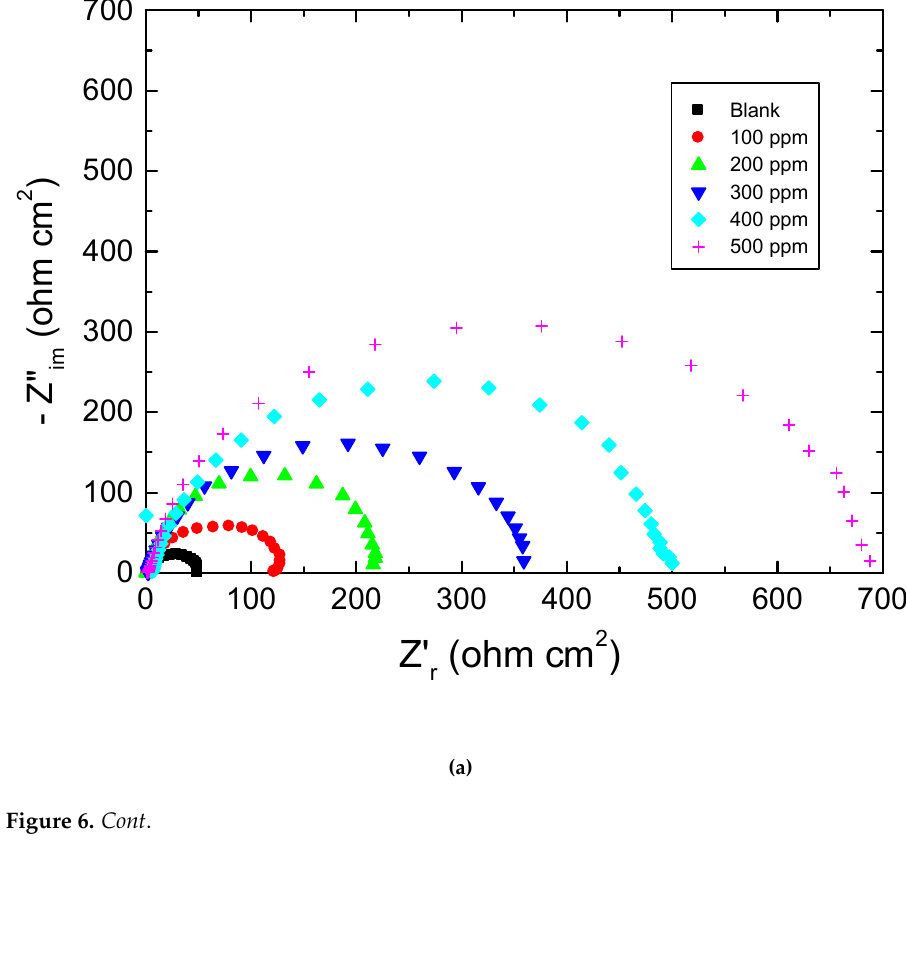
Figure 5. Plots of: (a) Nyquist, (b) Bode magnitude, and (c) Bode phase for mild steel in 0.5 M HCl solution at 303 K in absence and presence of pectin.